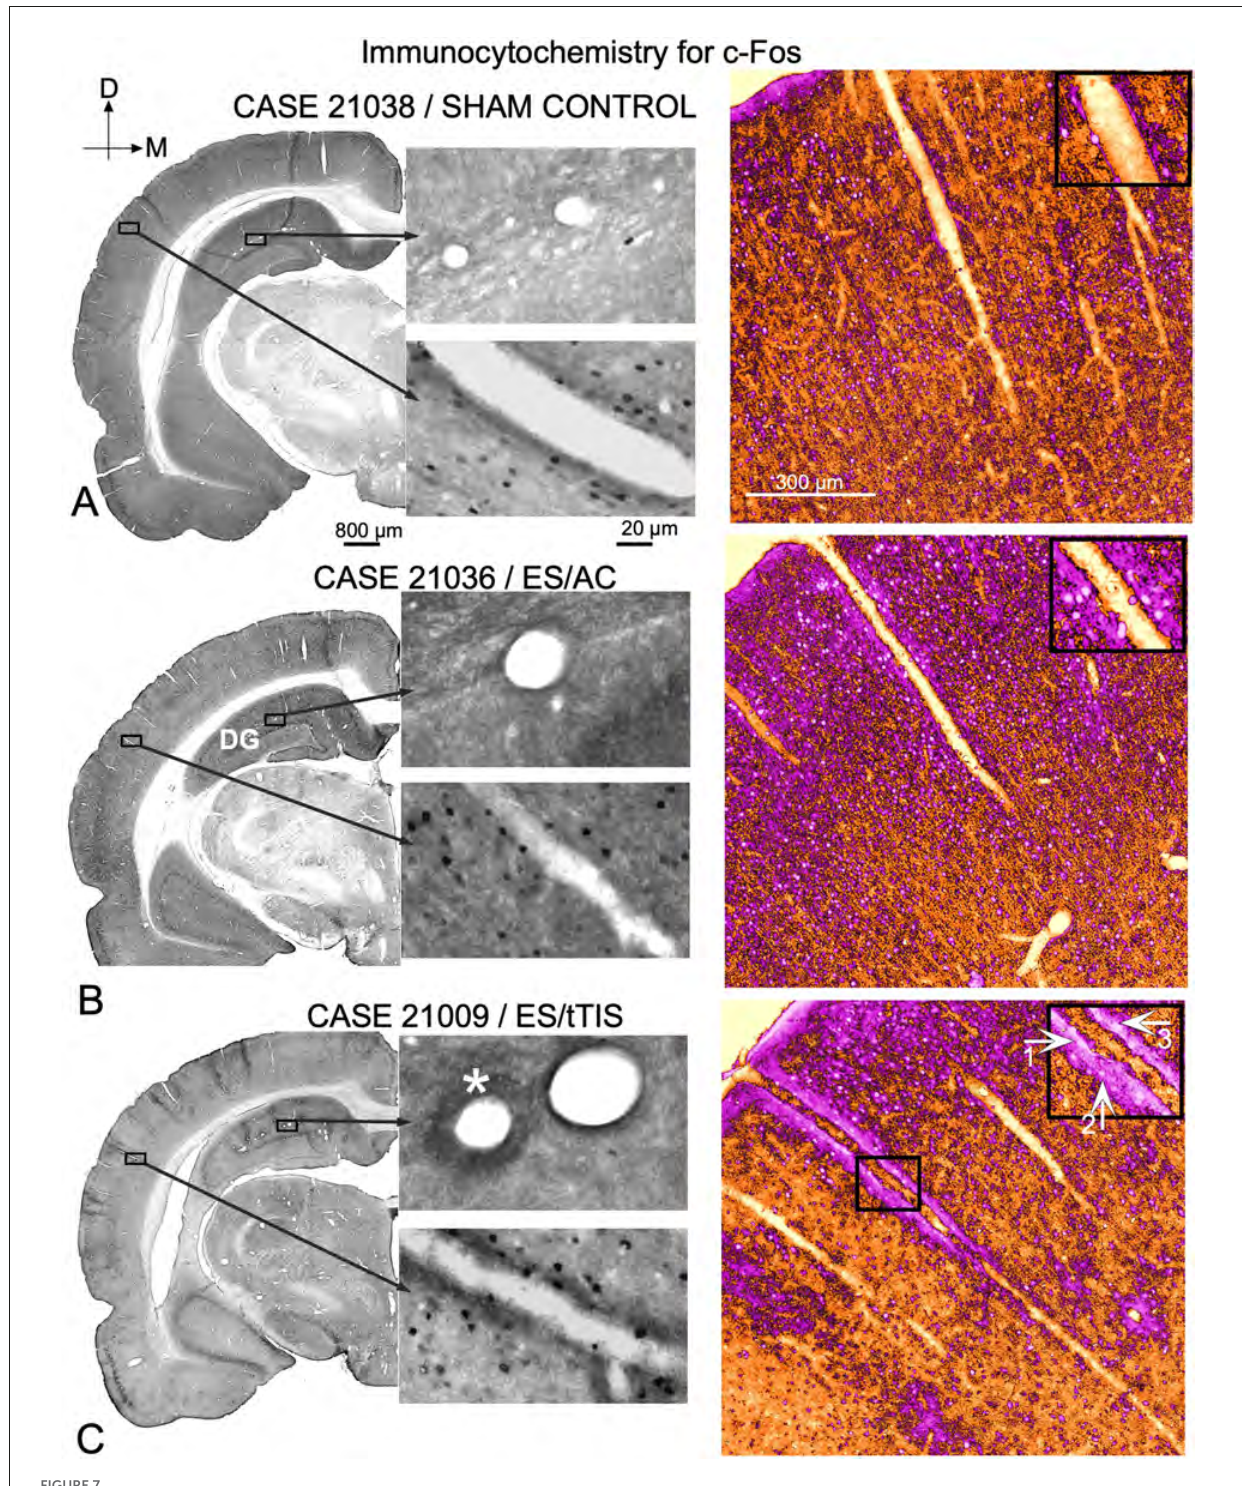
FIGURE7 c-Fos immunostaining of blood vessels. (A) SC group. (B) ES/AC shows increased immunoreactivity in superficial cortical layers of the cortex (C) ES/tTIS stained sections show increased immunoreactivity in blood vessels cells. Left column c-Fos immunostaining, non-modified pictures; right column—higher magnification details after ICA color conversion. Insets show details of blood vessels’ immunoreactivity in the three experimental conditions. In the inset in (C) white arrows point: 1- Endothelium; 2- Smooth muscle cell and 3- Pericytes.